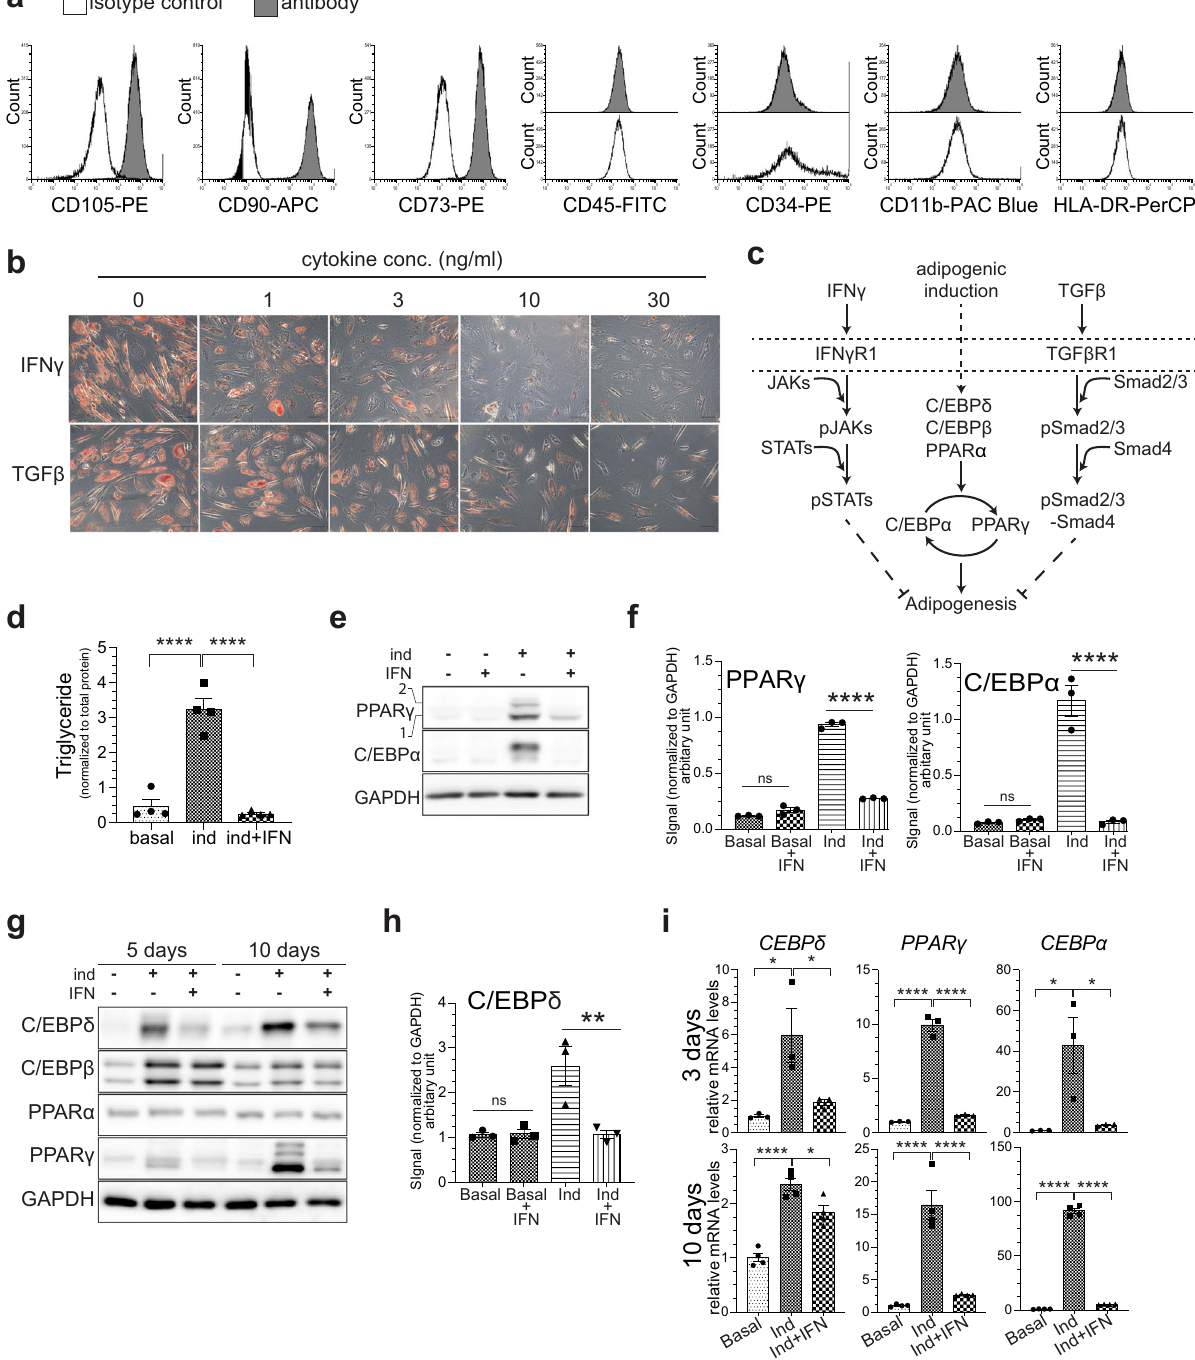
Fig. 1 IFN γ is a potent inhibitor of adipogenesis from human visceral adipose-derived MSCs. a Phenotypic characterization of human VA- MSC by fl ow cytometry. Representative fi gure ( N = 3) showing MSC-speci fi c marker expression (CD105 + CD73 + CD90 + CD45 − CD34 − CD11b − HLADR − ) in one hVA-MSC. b Representative ( N = 3) phase-contrast microscopy image of Oil Red-stained hVA-MSC after 14 days of adipogenic differentiation with/out human IFN γ and TGF β . Media, along with IFN γ or TGF β was changed every 48 h. c Schematic diagram depicting canonical IFN γ and TGF β signaling pathways and adipogenesis cascade. d Colorimetric triglyceride assay of hVA-MSC extract after 14 days of adipogenic induction with/out human IFN γ (10 ng/ml). Triglyceride levels were normalized to that of total protein ( N = 4). e , f Representative western blot analysis ( e ) and blot quanti fi cation ( f , N = 3) of hVA-MSC after 14 days of adipogenic stimulation with/out IFN γ (10 ng/ml). g Representative western blot analysis of hVA-MSC after 5 or 10 days of adipogenic differentiation with/out IFN γ (10 ng/ml). h Quanti fi cation of C/EBP δ band ( N = 3) after 5 days of adipogenic induction. i qRT-PCR quanti fi cation of cDNA prepared from hVA-MSCs after 3 or 10 days of adipogenic induction with/out IFN γ (10 ng/ml). Transcript levels were normalized to that of GAPDH ( N = 3/4). Ind-adipogenic induction. Normal cell culture media (Ind − IFN − ) treated cells were used as the basal condition. Error bars represent mean ± SEM. * indicates statistical signi fi cance (* P < 0.05; ** P < 0.005, *** P < 0.0005, **** P < 0.00005) of Tukey ’ s multiple comparisons test post one-way ANOVA